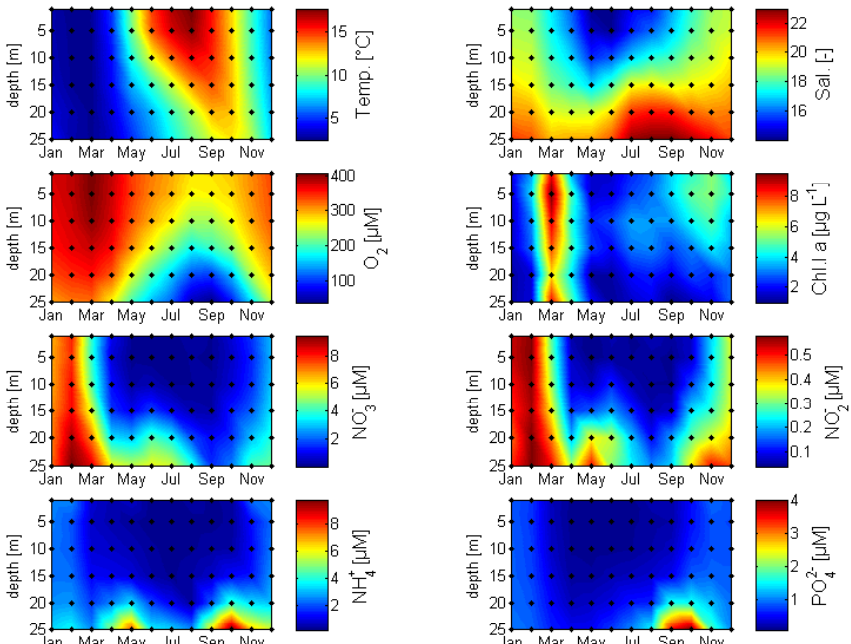
Figure 3. Mean seasonal cycle of temperature (1957–2013), salinity (1957–2013), oxygen (1957–2013), chlorophyll a (1960–2013), nitrate (1979–2013), nitrite (1986–2013), ammonium (1979–2013) and phosphate (1957–2013). The black dots indicate location (at six standard depths) and time (12 months) of measurements taken into account for interpolation.